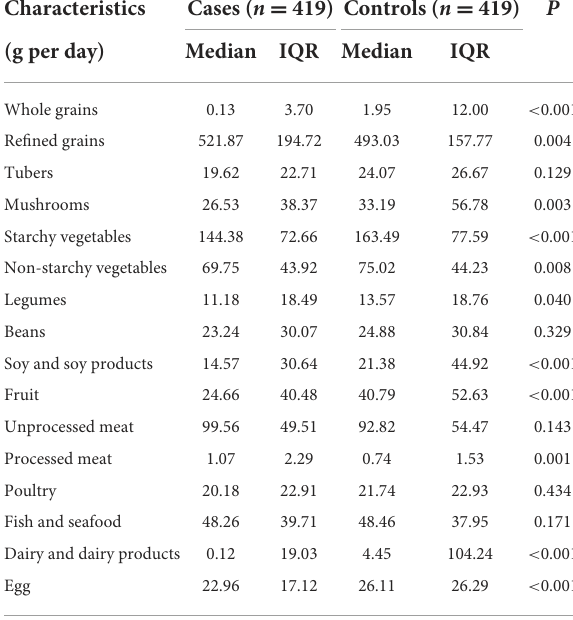
TABLE 4 Distribution of food group intake after energy-adjusted among 419 cases and 419 controls.